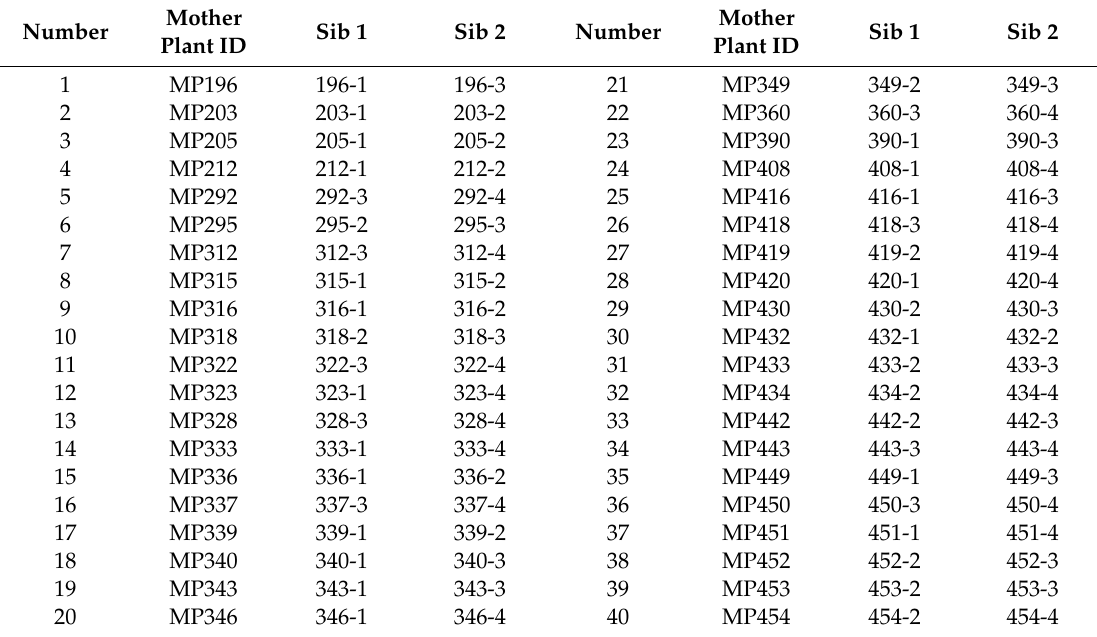
Table 1. C. Canephora families included in heritability